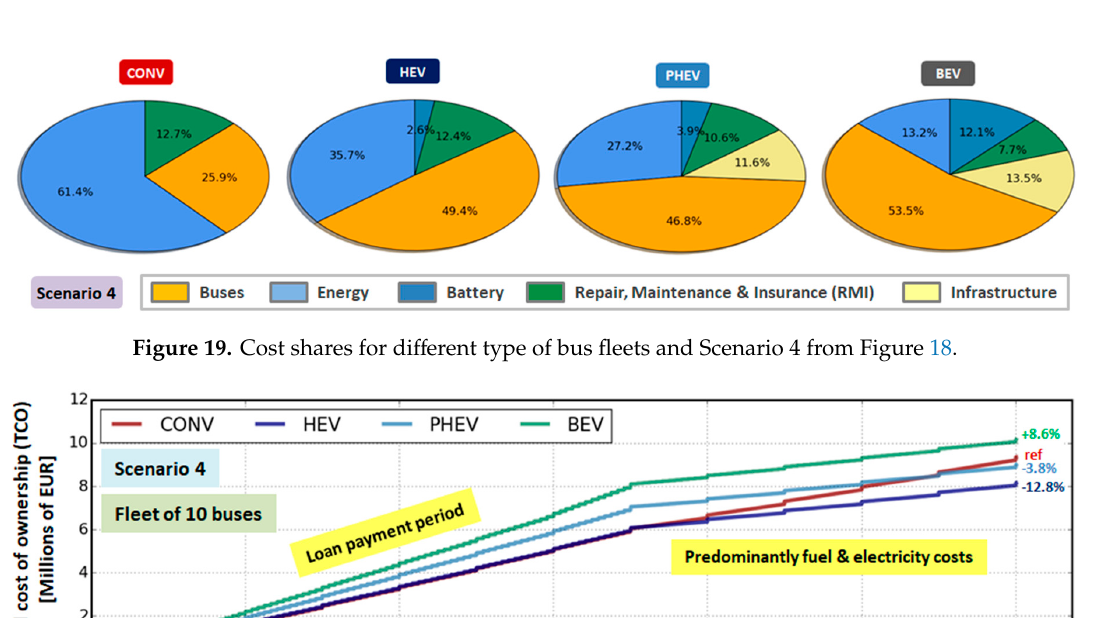
Figure 18. Comparative TCO values for different bus fleet types and electrification scenarios.